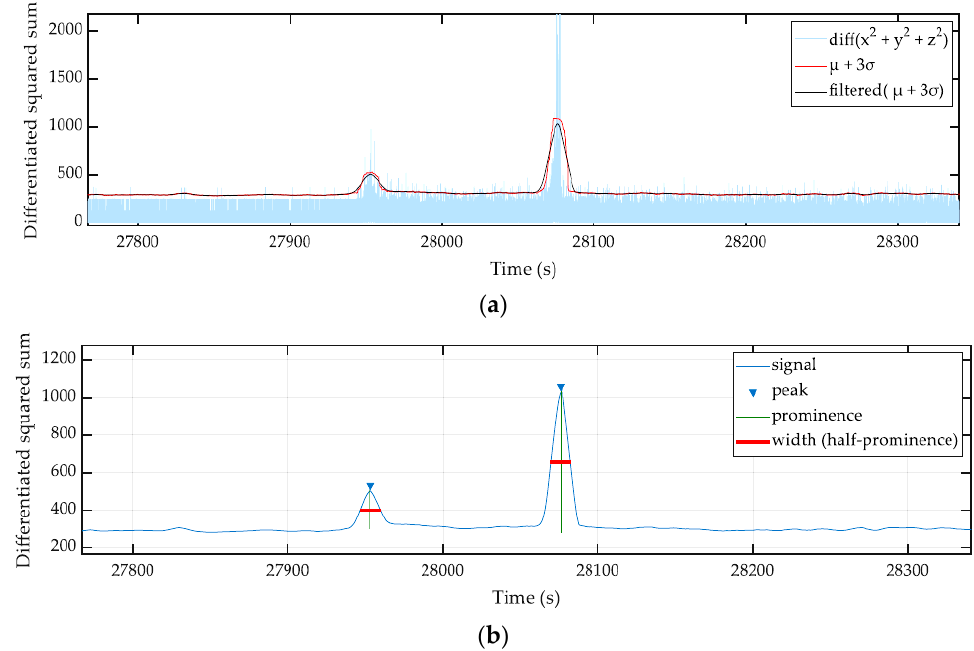
Figure 12. Visual interpretation of the algorithms to identify movements during sleep [117].